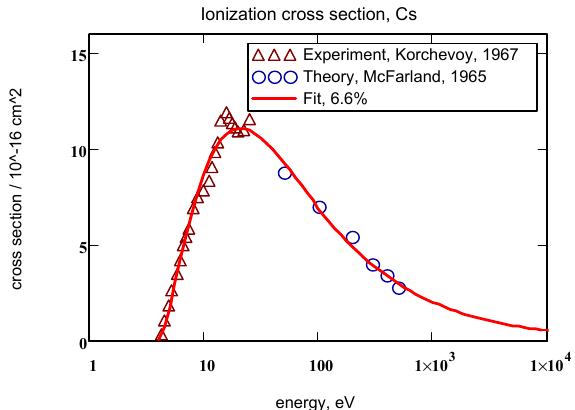
Figure 4. Experiment [11,28] and the result of approximation by the one − term Formula (6) of the ionization cross section of cesium atoms with a mean square relative error of 6.6%.